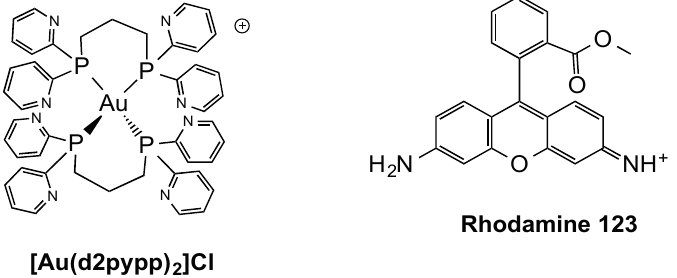
Figure 5. Examples of delocalized lipophilic cations (DLCs) including a Au(I)